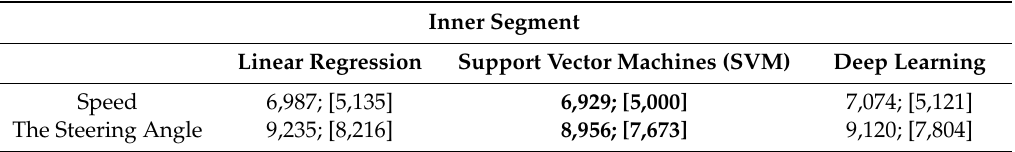
Table 3. Comparison of Root Mean Squared Error (RMSE) and Absolute Error (AE) metrics for vehicle speed and steering angle estimation.